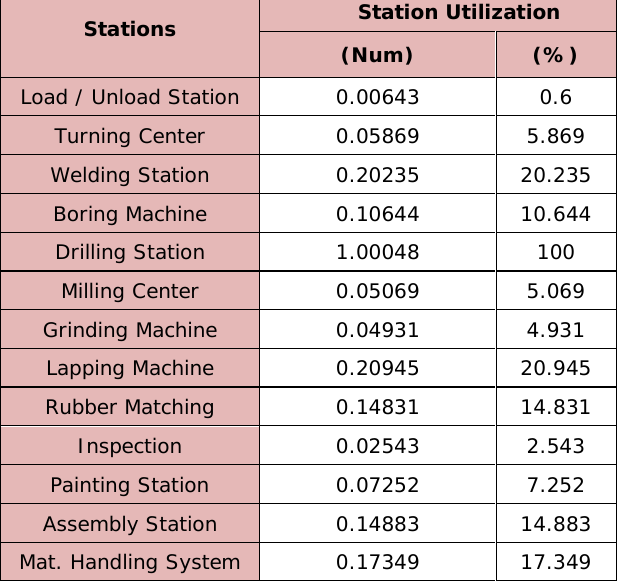
Table 4. Station Utilization. Source: Own